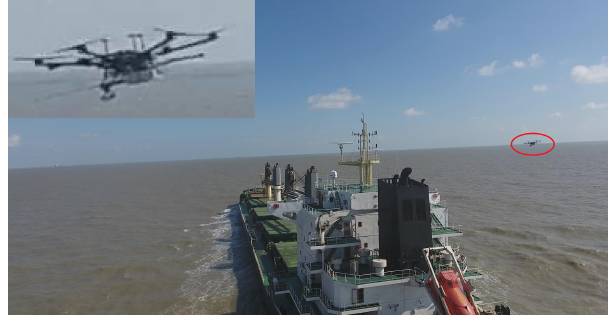
Figure 4. The UAV (marked by the red circle) monitoring a ship’s emissions in the open sea. The enlarged UAV is shown in the top left corner. This picture was captured by another